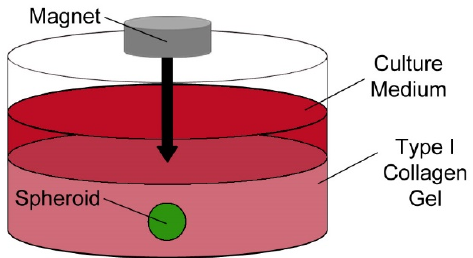
Figure 1. Schematic of three-dimensional spheroid culture. Following its formation, the spheroid is levitated in a type I collagen gel where it can be maintained for several weeks.